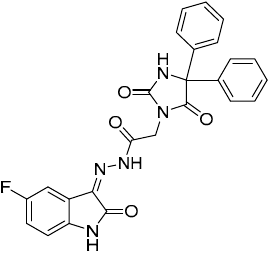
Figure 1. Molecular structure of the isatin derivative: Compound 16 [27], named HAA 2021 in the present study.